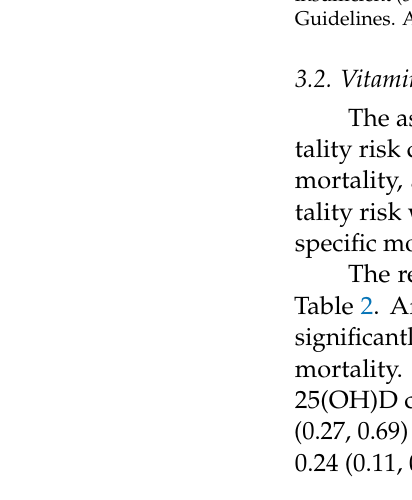
Table 2. HRs (95% CIs) for all-cause and cause-specific mortality according to serum 25(OH)D concentrations among OA patients in NHANES III and NHANES